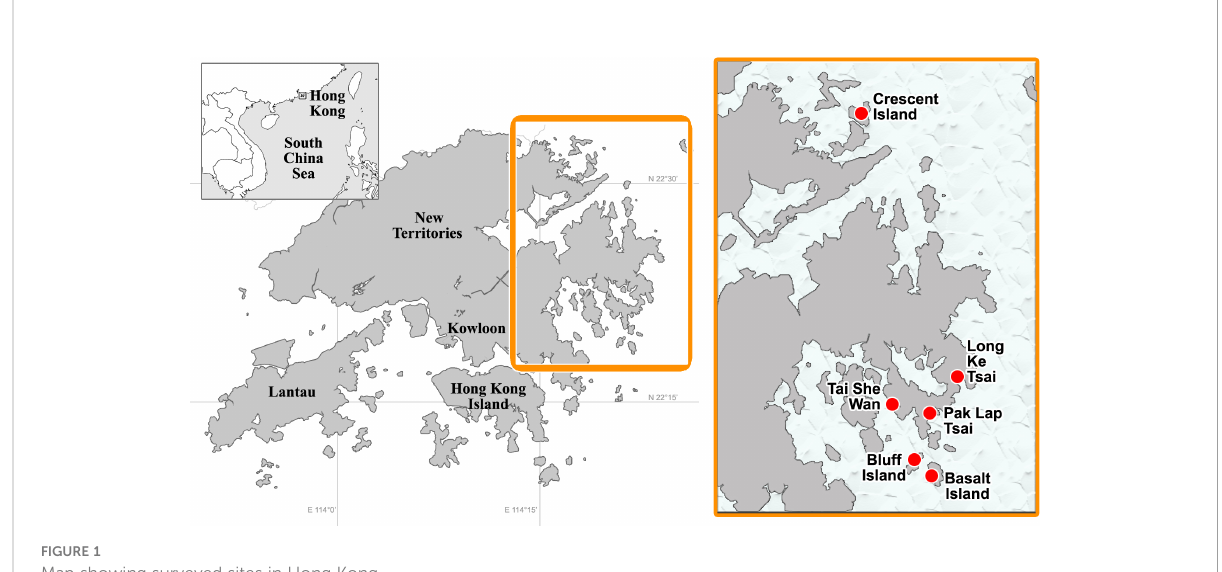
FIGURE 1 Map showing surveyed sites in Hong